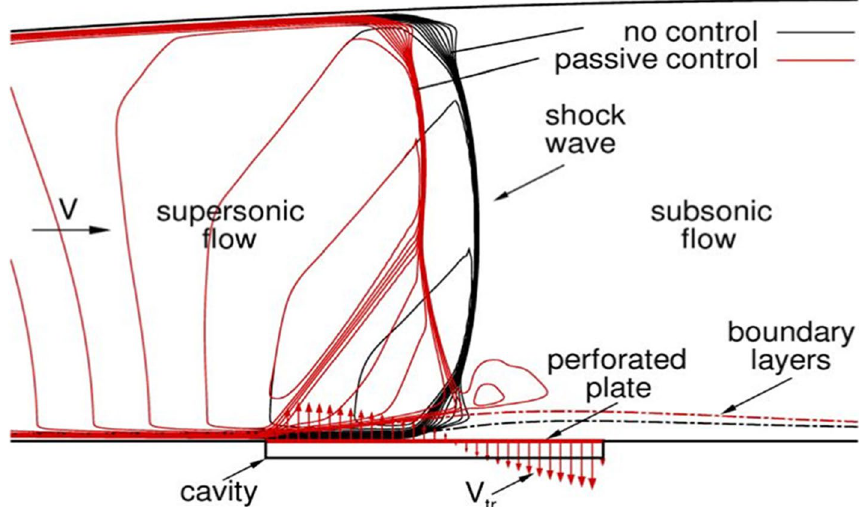
Fig. 9 Control of Shock/Boundary-Layer Interaction using porous cavity